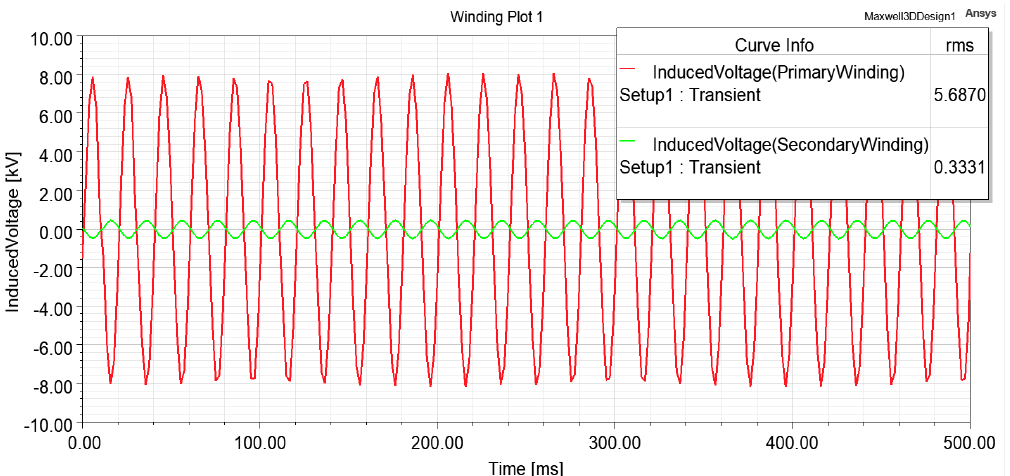
Figure 7. The RMS values of the induced voltages of the conventional transformer primary (red line) and secondary (green line) copper windings.